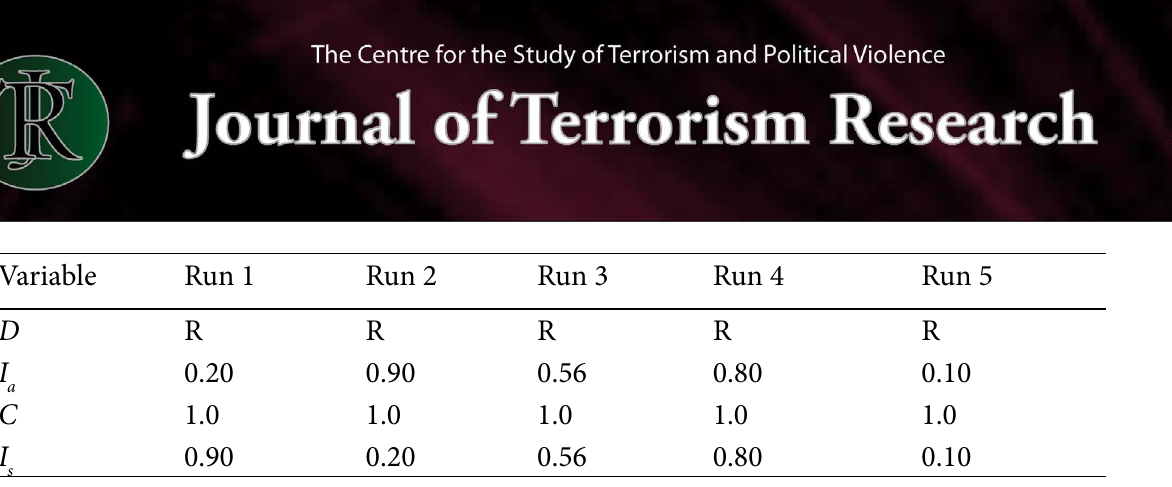
Table 1. Input assumptions for runs